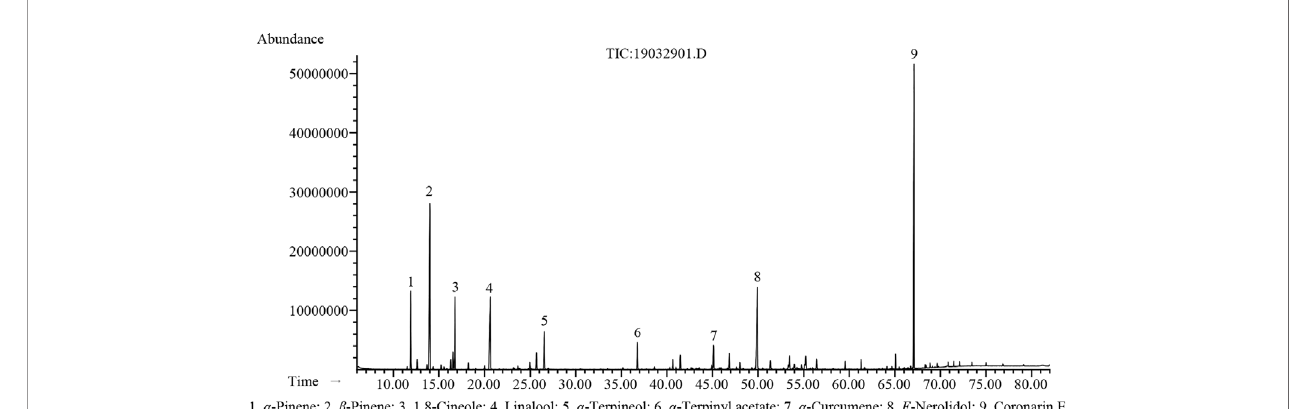
FIGURE 1 | GC-MS chromatogram of H. fl avum EO.